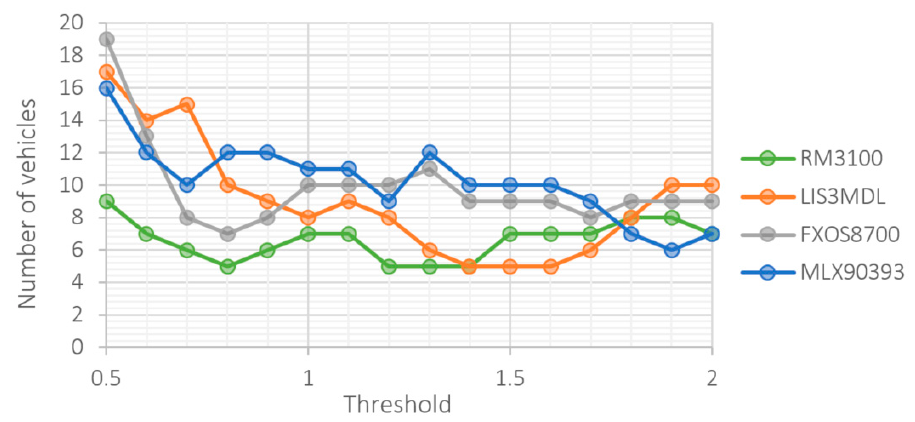
Figure 10. Number of false positives at different threshold level.